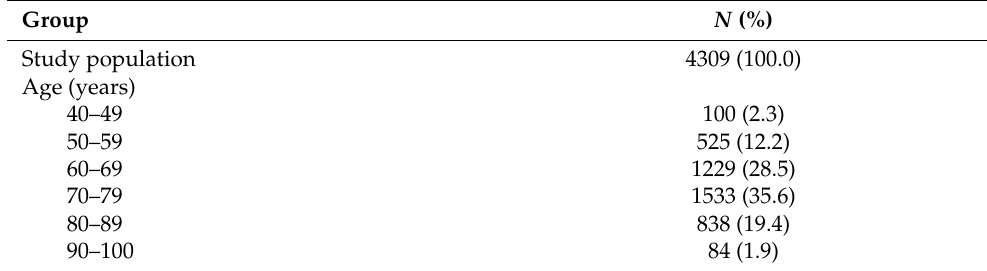
Table 1. General characteristics of the study